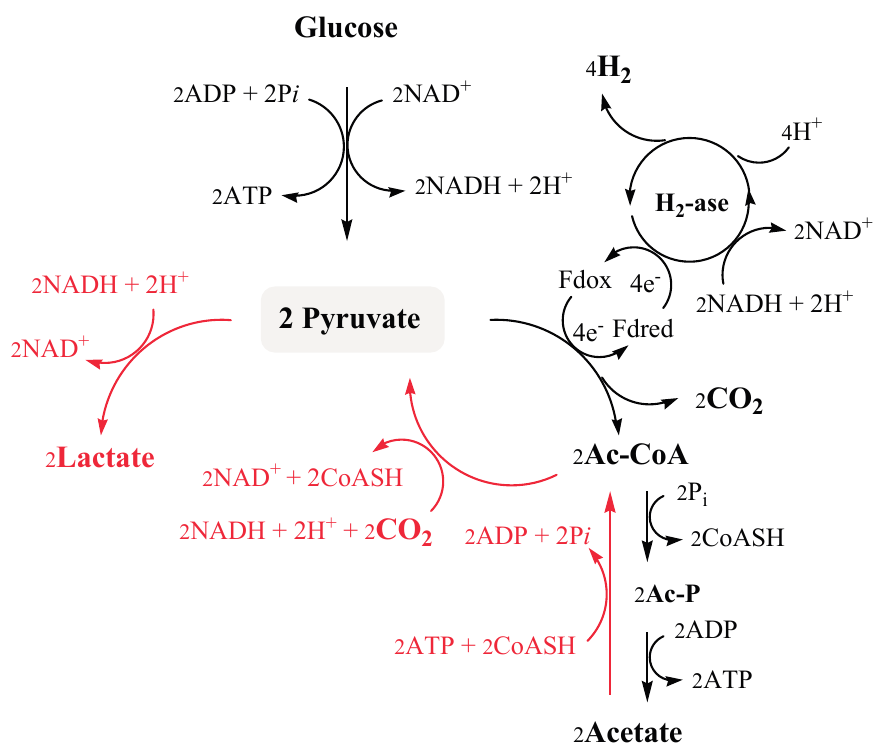
Figure 2. Proposed model of capnophilic lactic fermentation, adapted from [57]. Water is omitted for